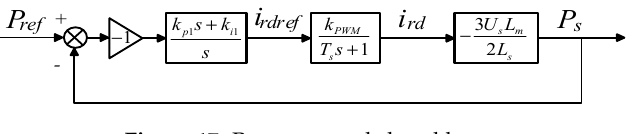
Figure 17. Power control closed loop.